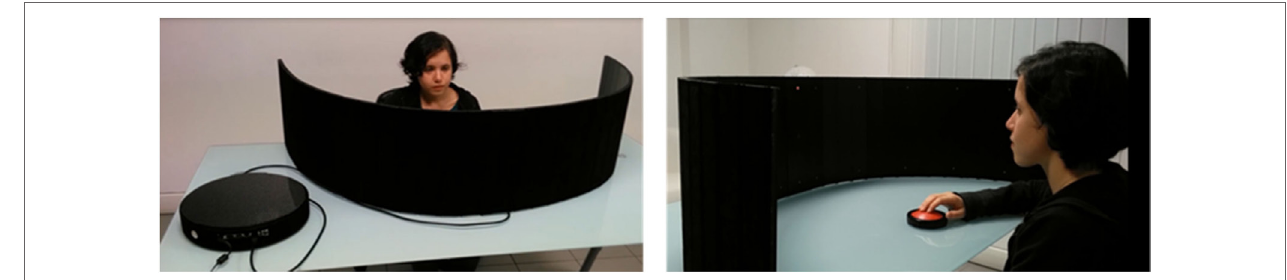
FIgUre 3 | Hardware of training